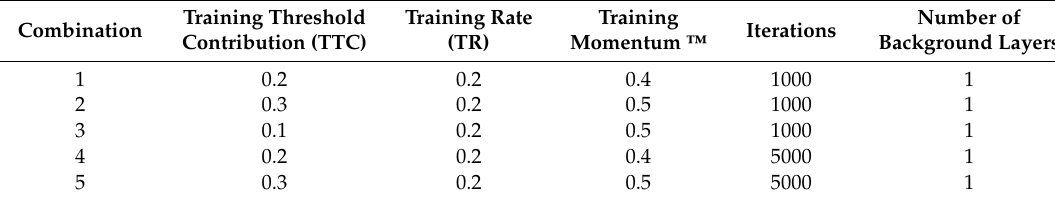
Table 4. Applied neural network (NN) parameters to L8 and WV2